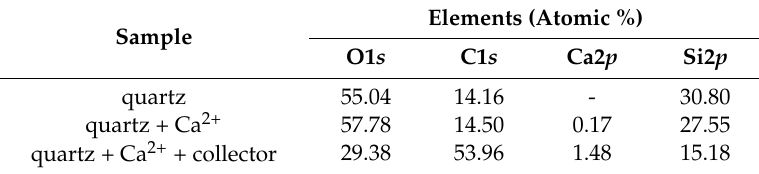
Table 4. Atomic percent of elements for quartz surfaces in various conditions (pH =